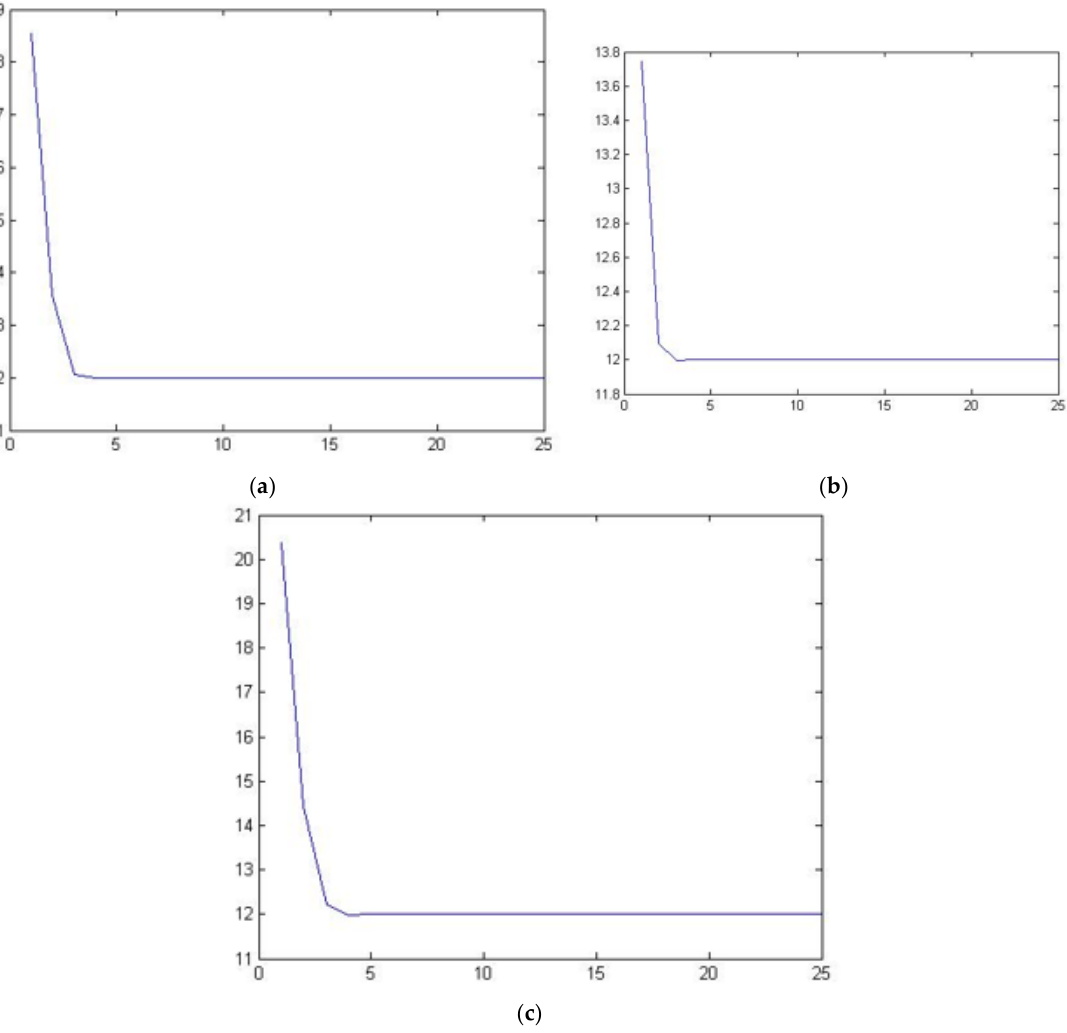
Figure 4. Improved artificial bee colony algorithm (IABCA) inversion convergence curve. (a) First inversion; (b) Second inversion; (c) Third inversion.